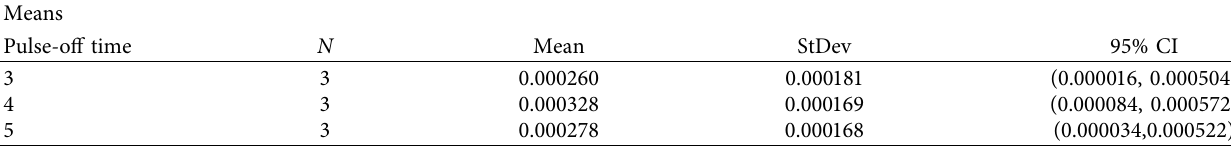
Table 21: Means and standard deviation for different pulse-off times for mild